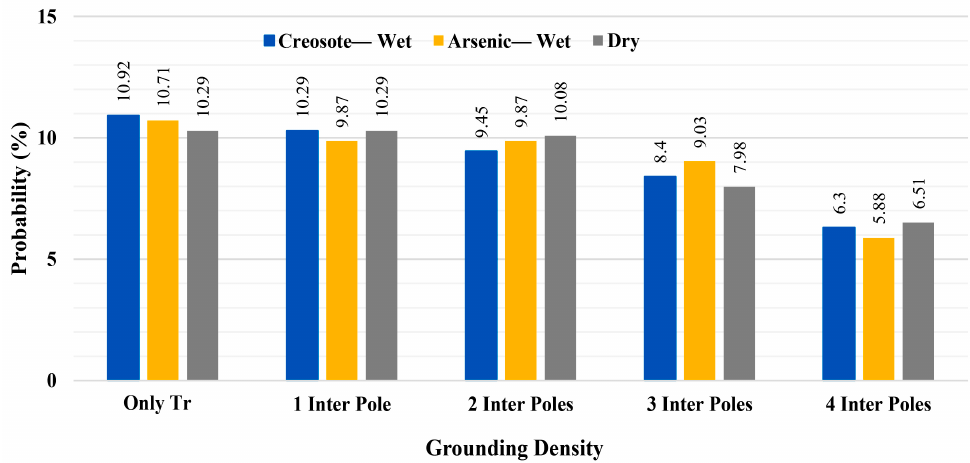
Figure 18. Comparison among the probabilities of transformer overvoltage stress above 30 kV under different grounding conditions, Case 2.